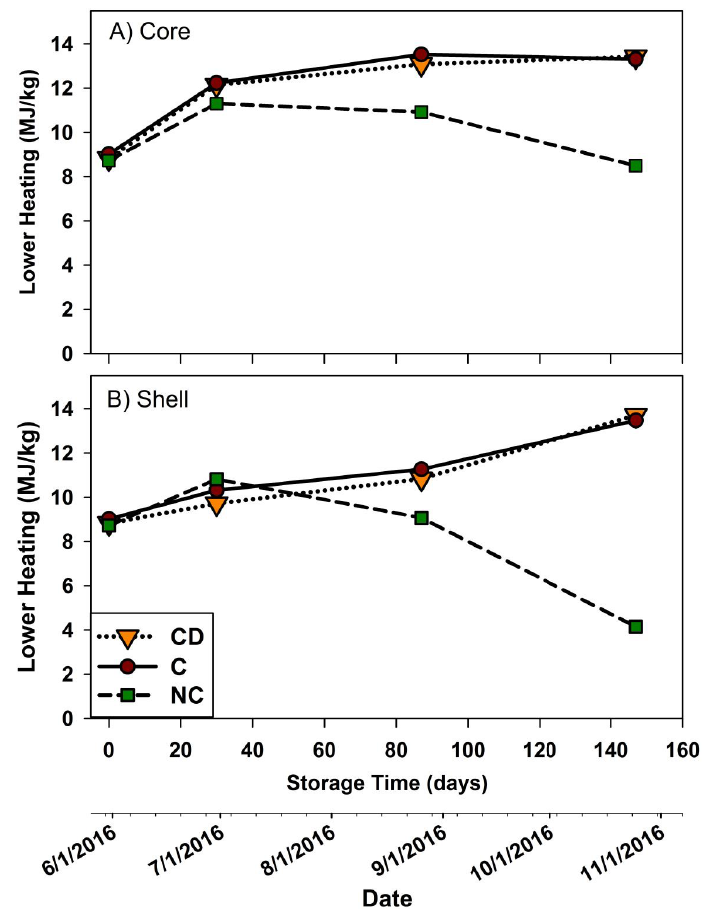
Figure 6. Variation of the lower heating value of willow and poplar wood chips stored for five months in piles with three different treatments (NC — no cover on pile; C — covered pile; CD — covered pile with dome ventilation); A) samples from the core; B) samples from the shell. The interaction between depth, position, and period was significant for the LHV ( p = 0.051). 50 The LHV of the core samples from the side of the piles was 11.3 MJ/kg, and was not significantly 51 different than the LHV of the core samples from the top ( p = 0.79) and the shell samples from the 52 side ( p = 0.23) for the entire storage trial. However, the LHV of the shell samples from the top of the 53 piles was 9.2 MJ/Kg, which was significantly lower than the LHV of the shell samples from the side 54 (1.1 to 3 MJ/kg) and the core samples from the top (1.5 to 3.3 MJ/kg). 55